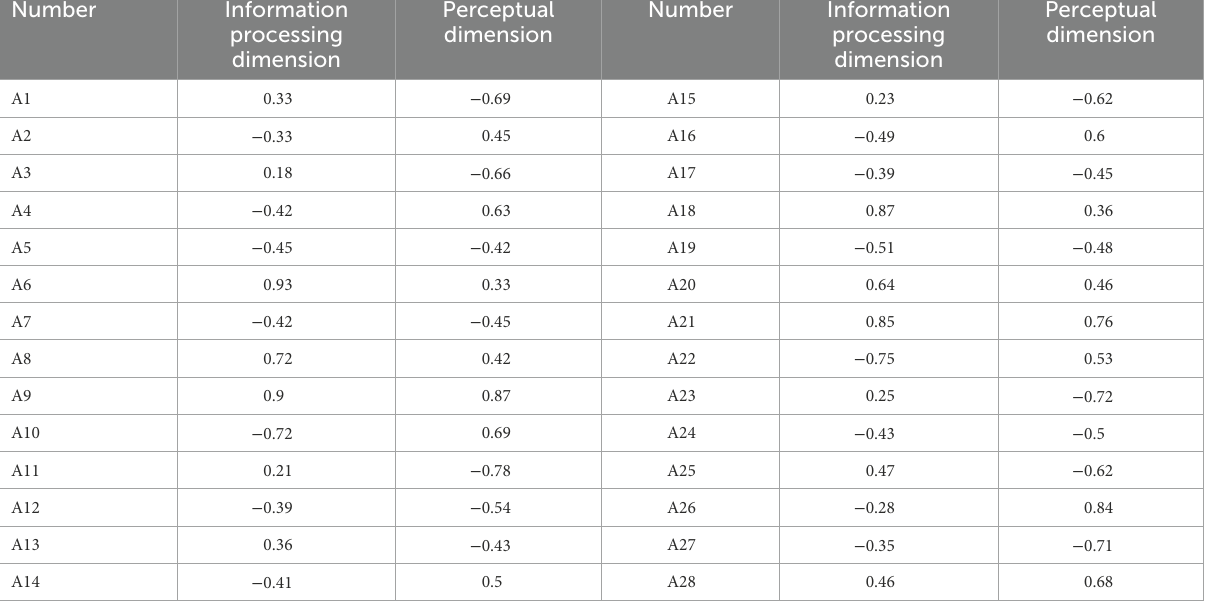
TABLE 2 Learning style